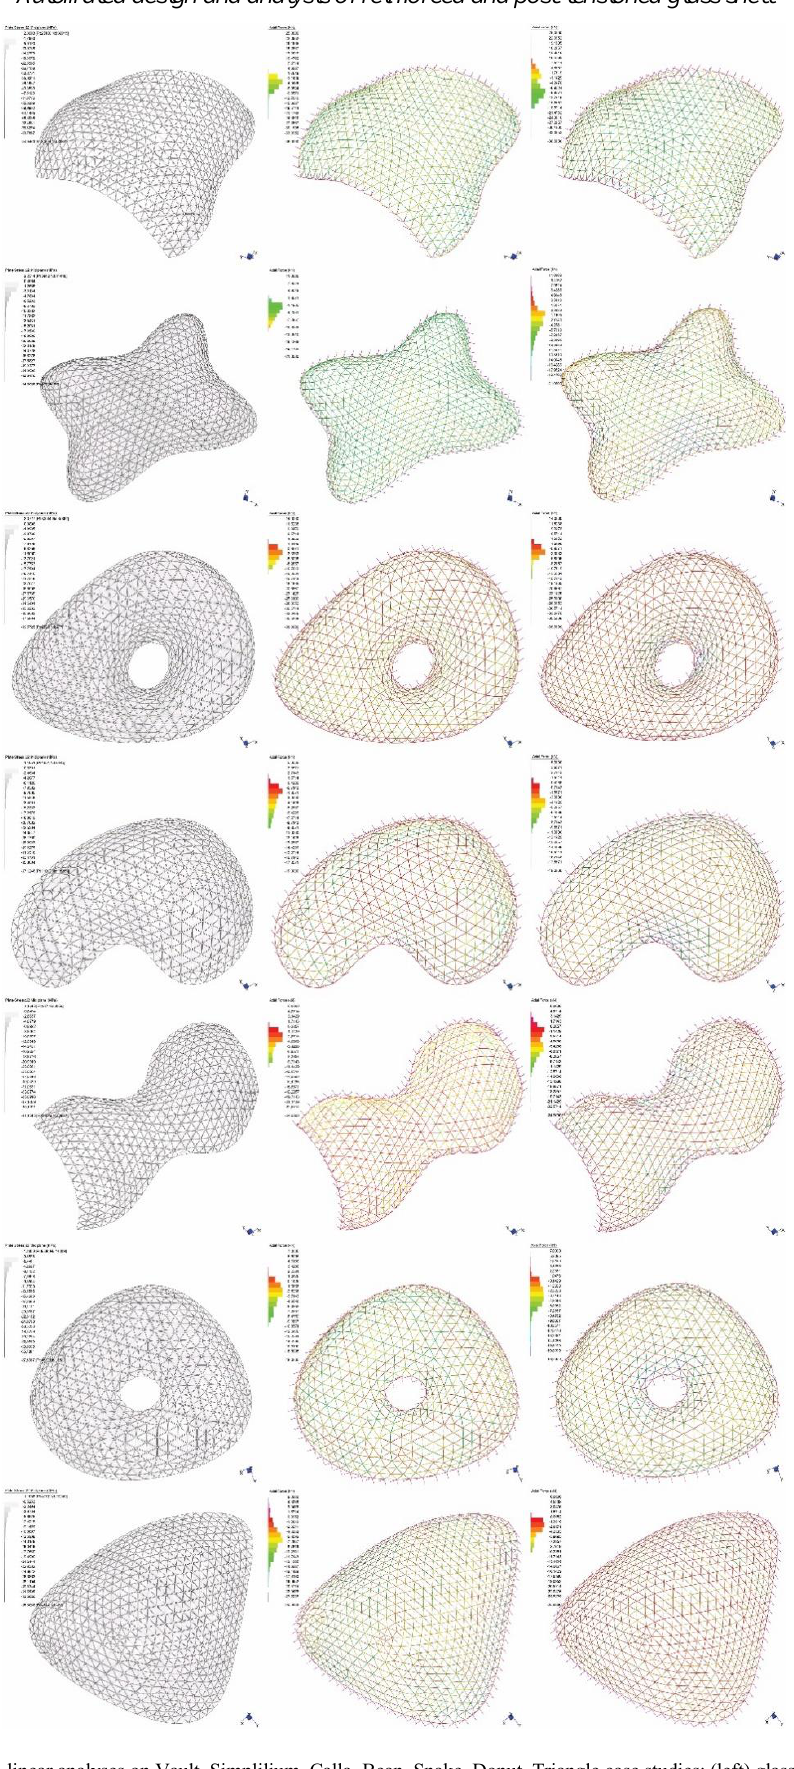
Fig. 9 Results of non-linear analyses on Vault, Simplilium, Calla, Bean, Snake, Donut, Triangle case studies: (left) glass minimum principal stress at SLS; (center) truss axial forces at the ULS; (right) axial forces in the WCS (glass as dead